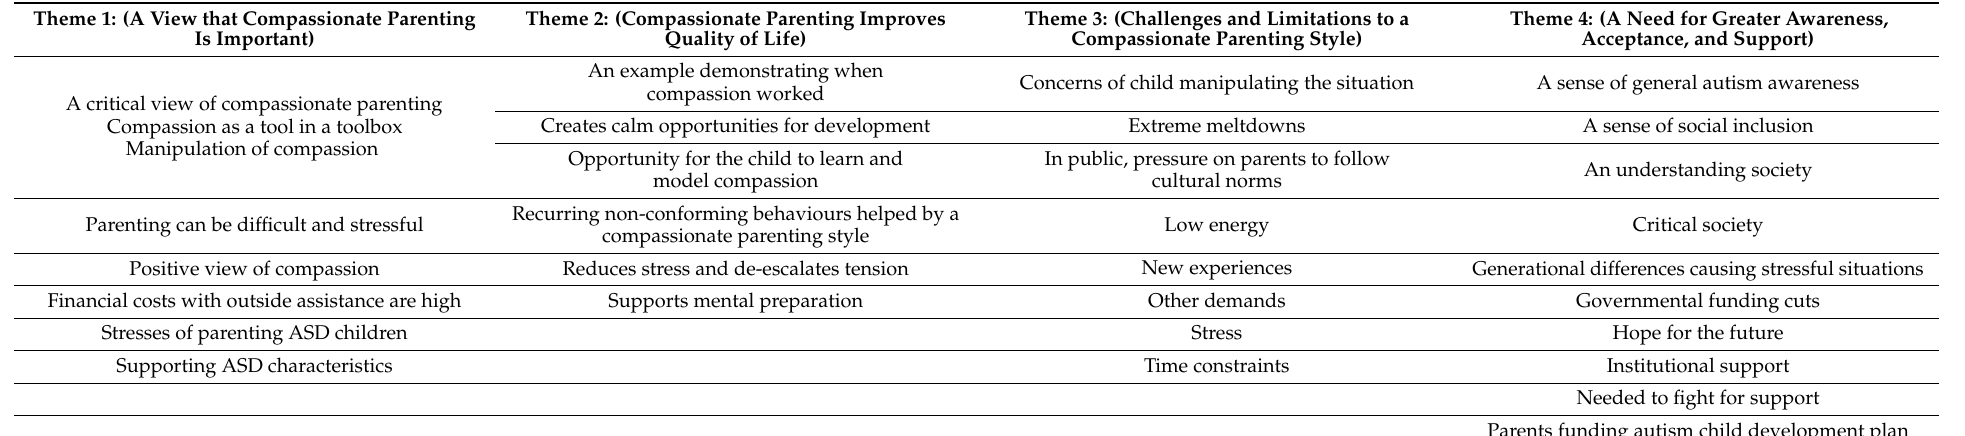
Table 1. Themes and